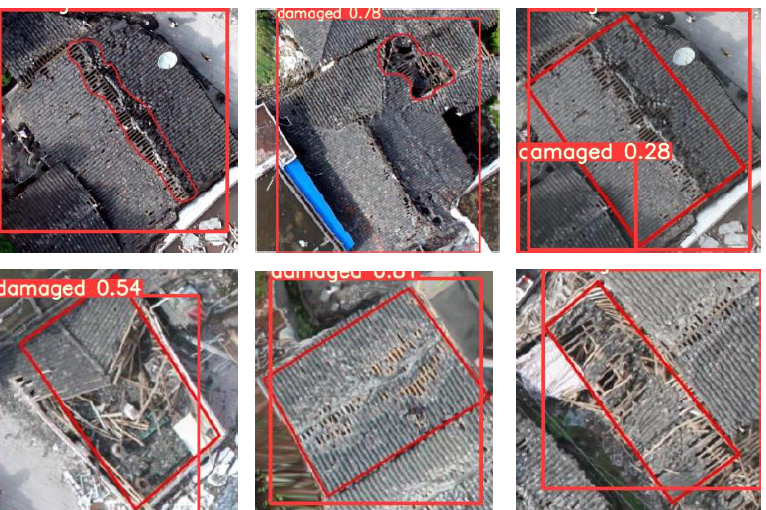
Figure 16. The samples for UAV images of different types of houses damaged by the Ya’an Ms7.0 earthquake on 20 April. The red vertical bounding boxes are the results of our method. The red irregular polygons are the annotations from references [8,9].